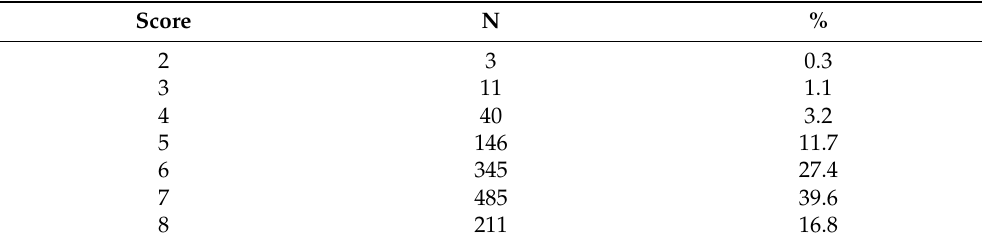
Table 4. Sum score of knowledge-based questionnaire (missing n = 88